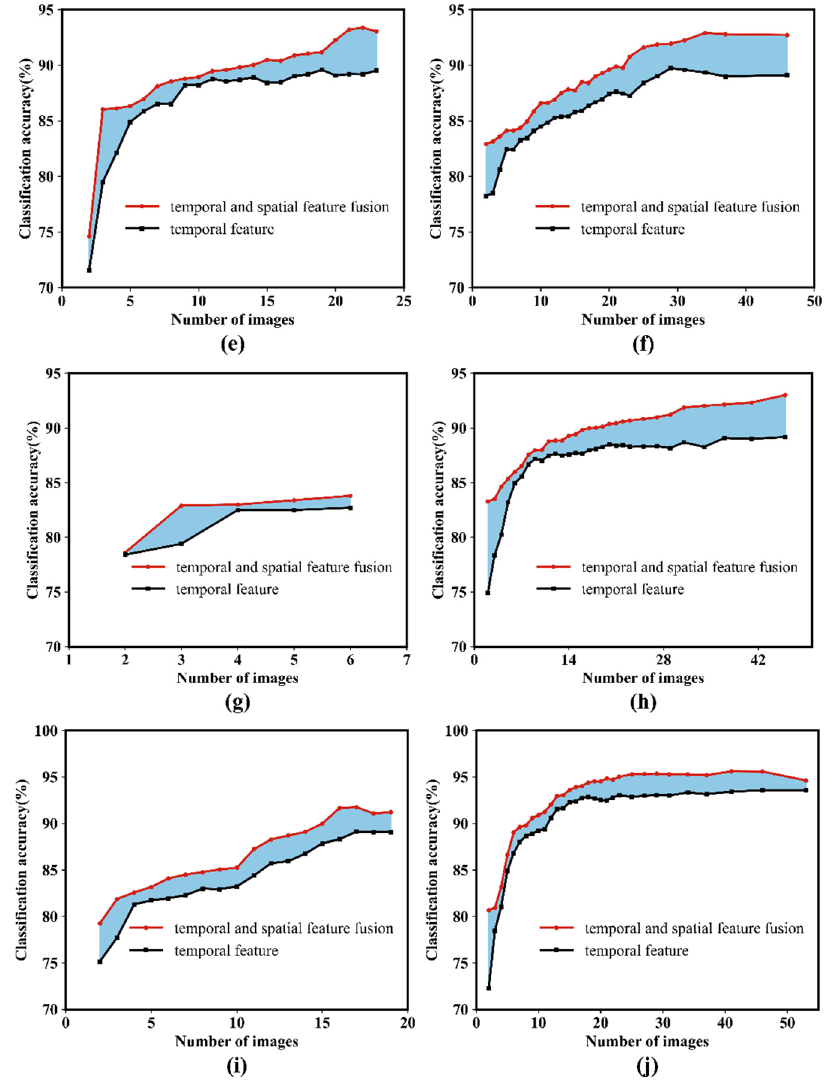
Figure 13. The growth of OA after fusion of spatial features with Landsat ( a , c , e , g , i ) temporal features and Sentinel-2 ( b , d , f , h , j ) temporal features for the five study areas. Table 7. The number of images for which the change in temporal features tends to smooth the OA using only temporal features, a combination of spatial and temporal features, and a combination of spatial and temporal features after adding new